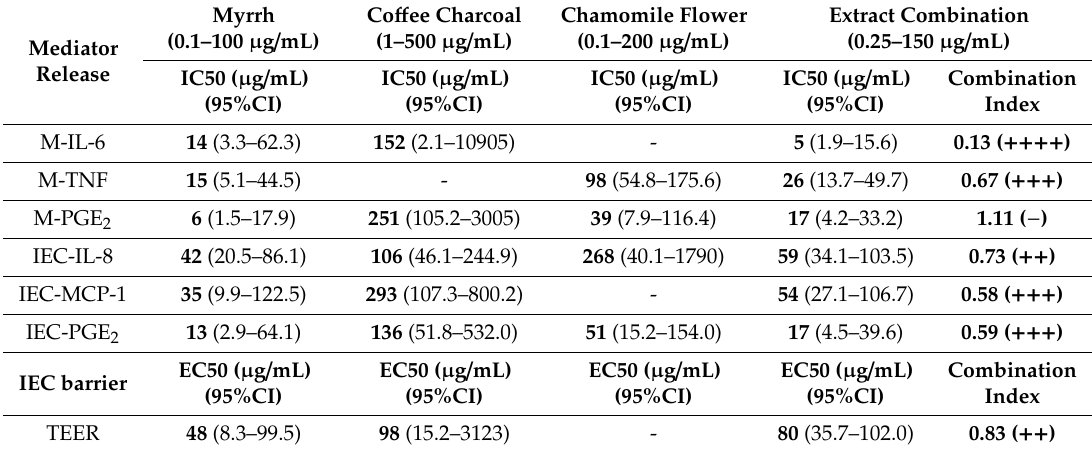
Table 1. Pharmacological interaction within the ternary combination of equal parts of myrrh, co ff ee charcoal and chamomile flower extract. Summary of the half-maximal inhibitory or e ff ective concentrations (IC / EC50) and the respective combination indices for the e ff ects on inflammatory mediator release from the THP-1 macrophages (M; IL-6, TNF, PGE 2 ) and intestinal epithelial cells (IECs; IL-8, PGE 2 ) and transepithelial electrical resistance (TEER) after 48 h stimulation and treatment. 95%CI = 95% confidence interval, ( ++++ ) = strong synergism, ( +++ ) = synergism, ( ++ ) = moderate synergism, ( − ) = slight antagonism.